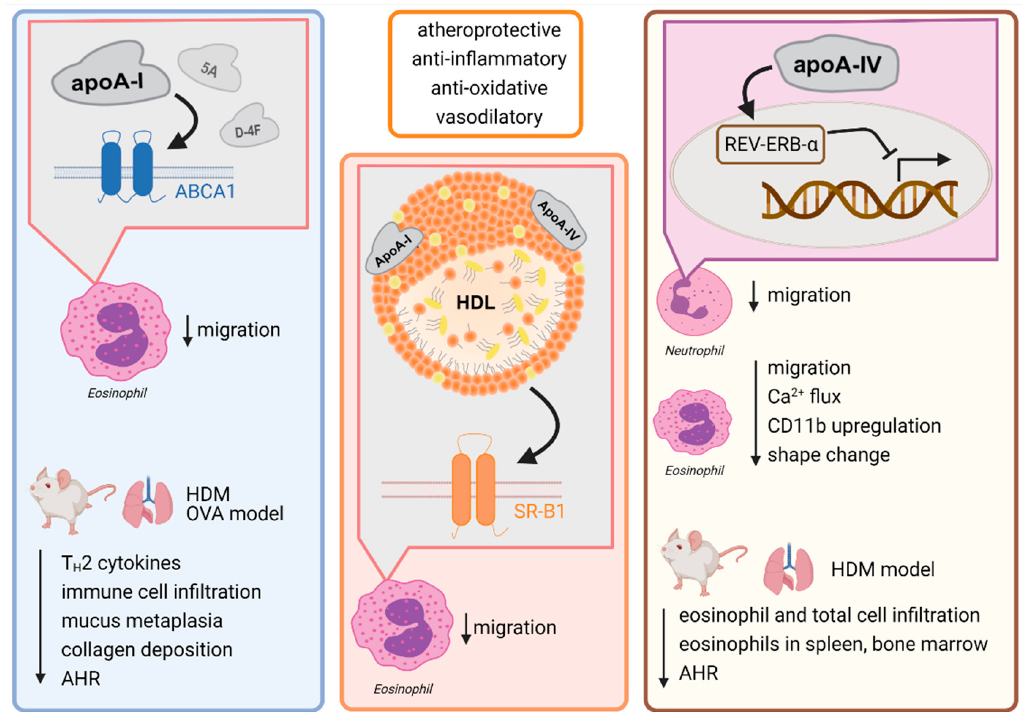
Figure 1. HDL and its components apolipoprotein A-I and apolipoprotein A-IV exhibit immunomodulatory actions via its receptors leading to amelioration of allergic inflammation. Abbreviations: ABCA1, ATP binding cassette subfamily A member 1; AHR, airway hyperresponsiveness; apoA-I, apolipoprotein A-I; apoA-IV, apolipoprotein A-IV; Ca 2+ , calcium; HDL, high-density lipoprotein; HDM, house dust mite; OVA, ovalbumin; SR-B1, scavenger receptor class B type 1.